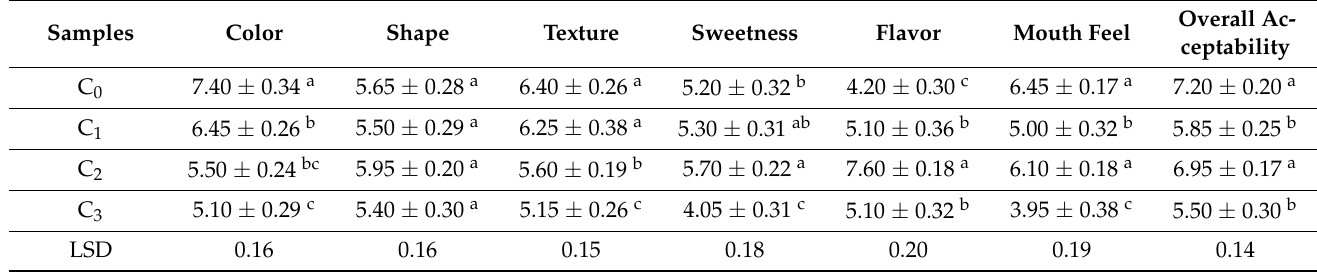
Table 5. Sensory attributes of cake fortified with MOLP and RBF.